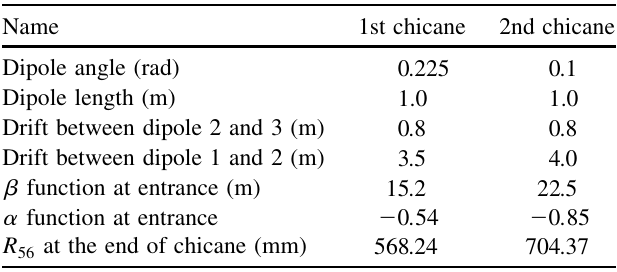
TABLE III. Parameters of the zigzag-type bunch